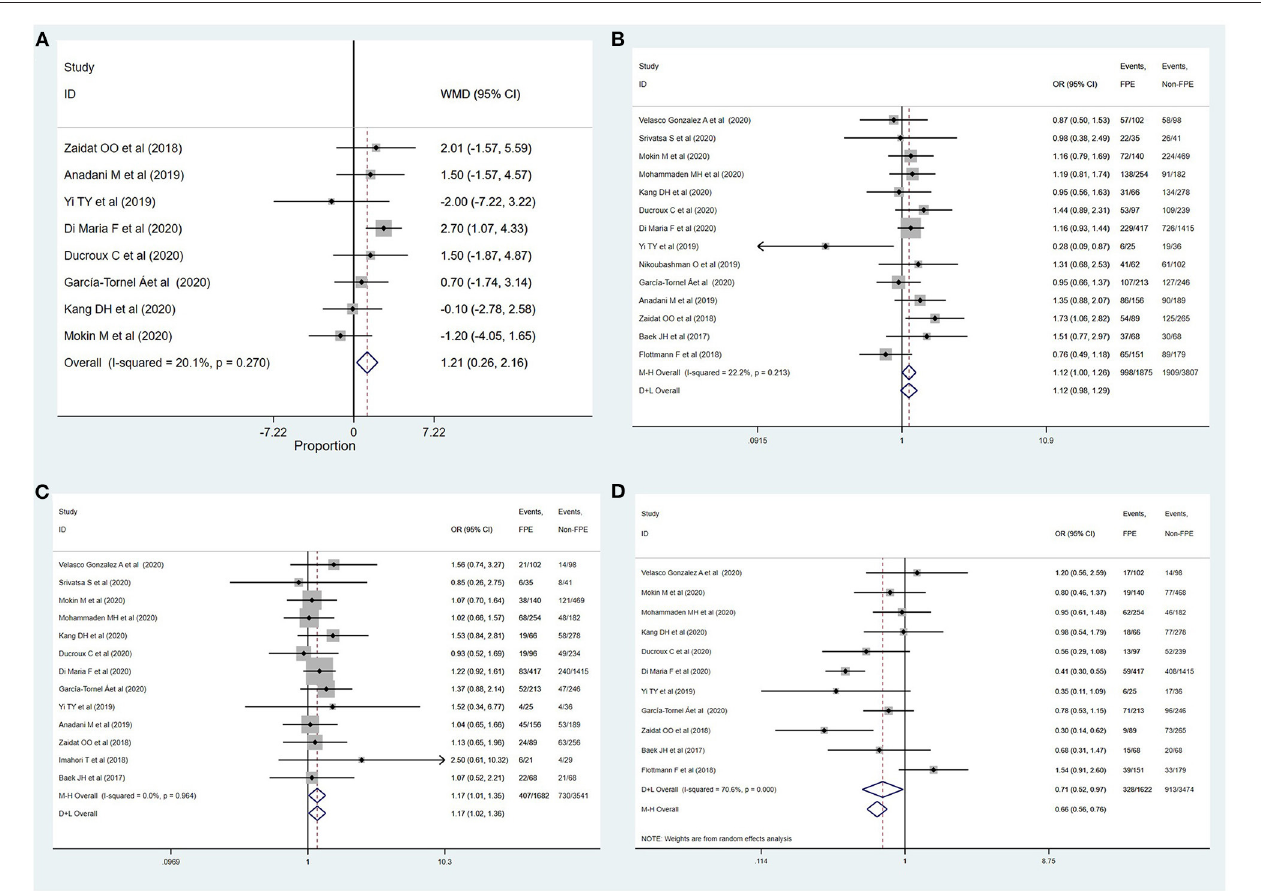
FIGURE 2 | Determinants of achieving successful recanalization with FPE. (A) Age; (B) female; (C) diabetes mellitus; (D) ICA.